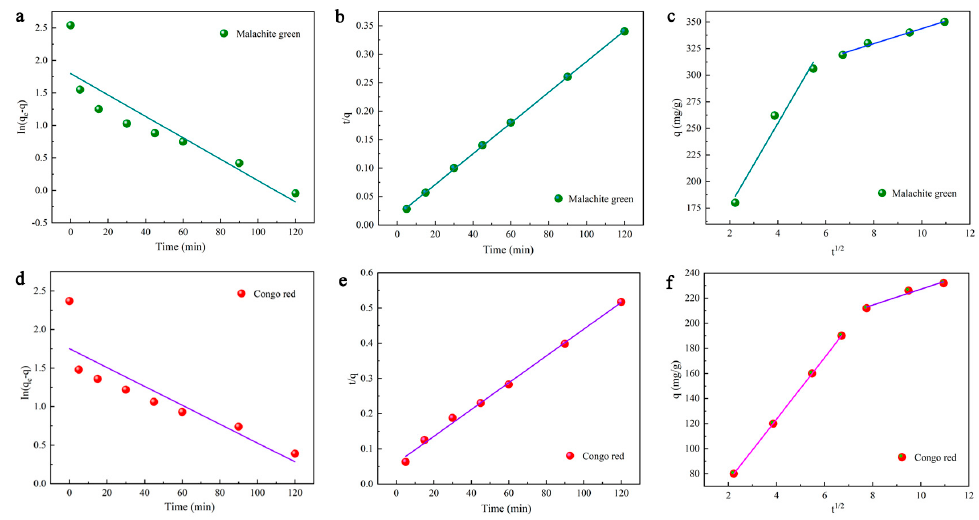
Figure 7. Adsorption kinetic studies of dye adsorption onto DMAL, pseudo-first-order model of MG ( a ) and CR ( d ); pseudo-second-order model of MG ( b ) and CR ( e ); intragranular model of MG ( c ) and CR ( f ). Table 4. Adsorption kinetics constant and parameter values.